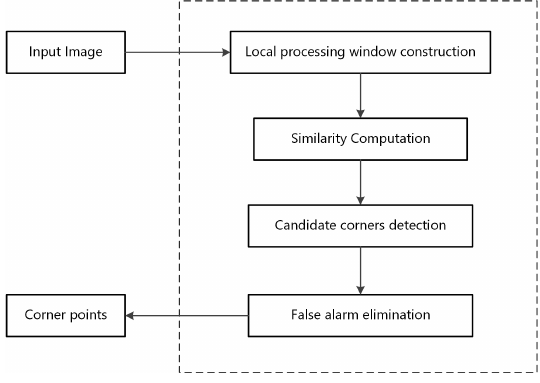
Figure 1. Flow chart of the proposed detector